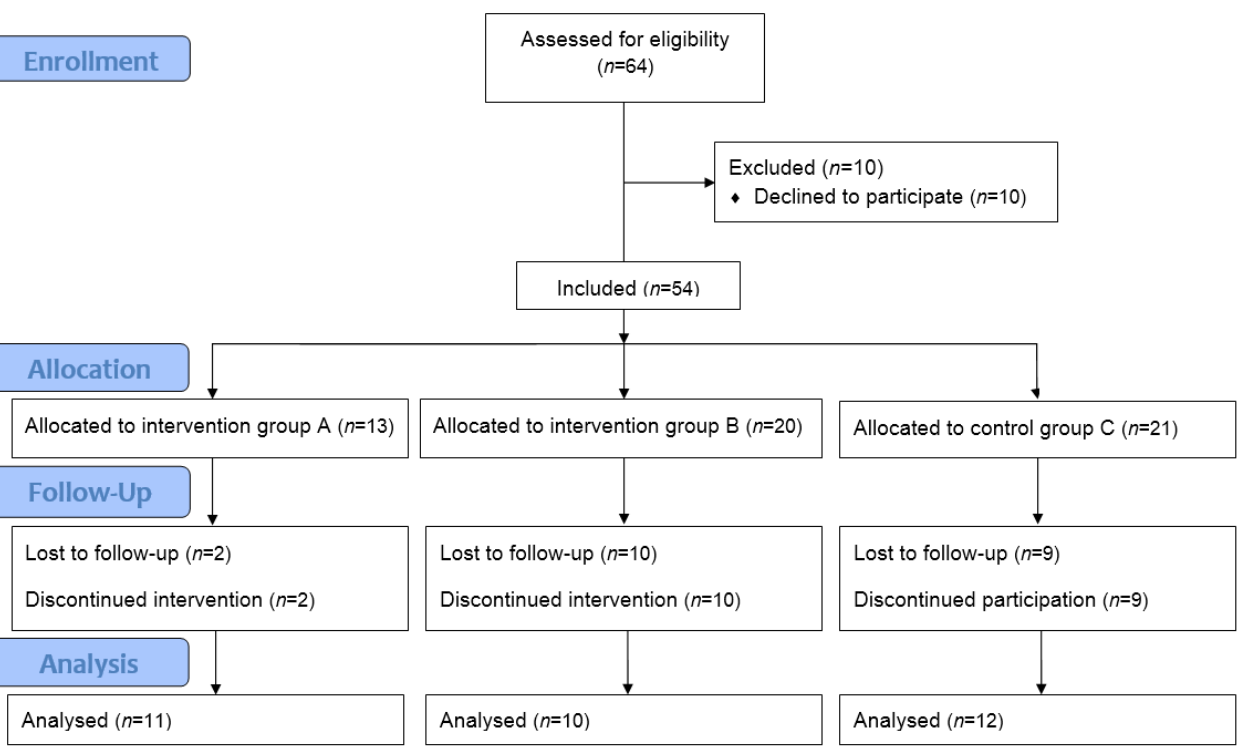
Figure 1. CONSORT 2010 Flow Diagram [26].